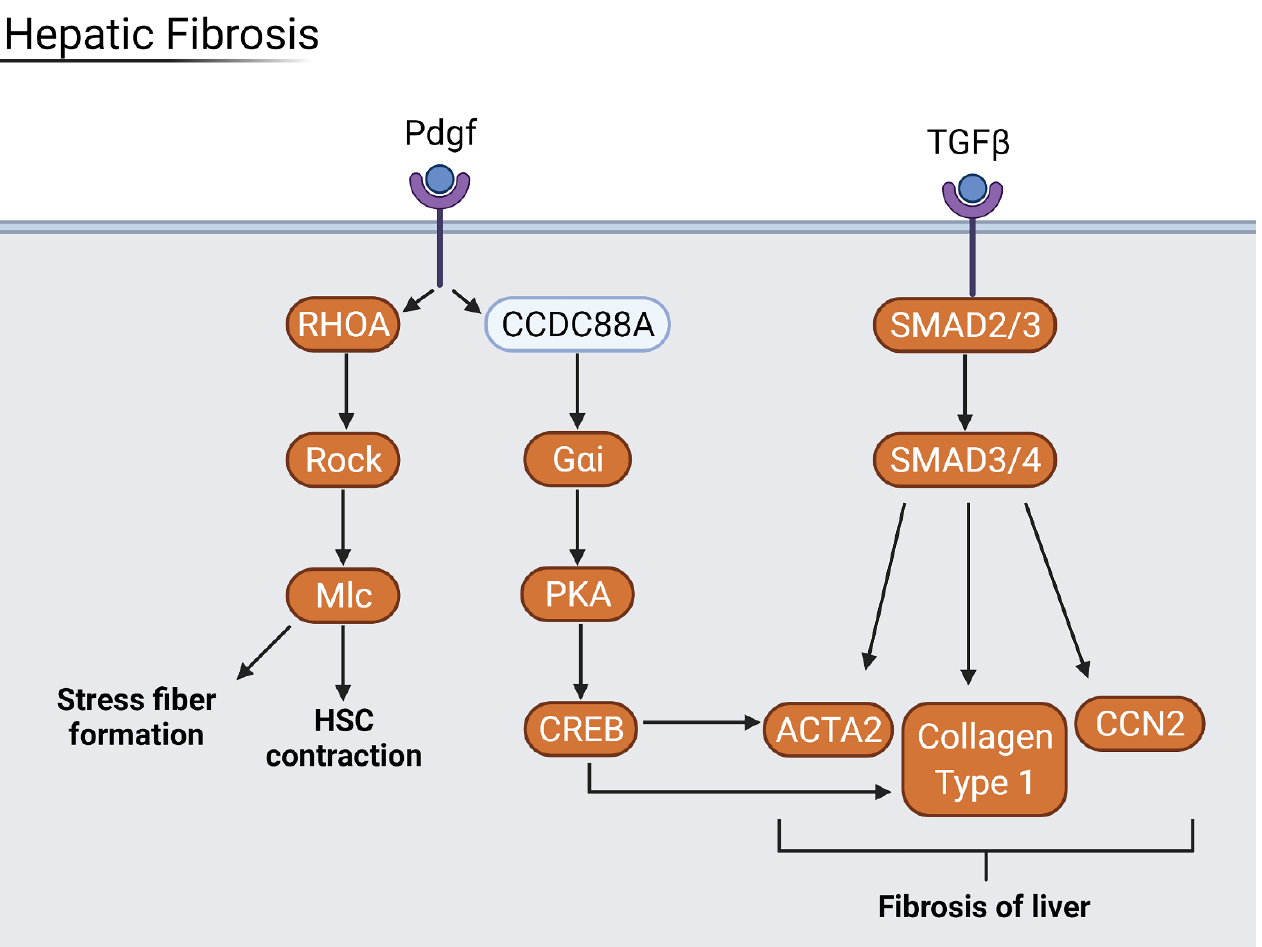
Figure 11. Hepatic Fibrosis pathway where orange proteins are upregulated. COVID-19 infection stimulates the fibrotic pathway via the upregulated genes. Generated in Biorender.